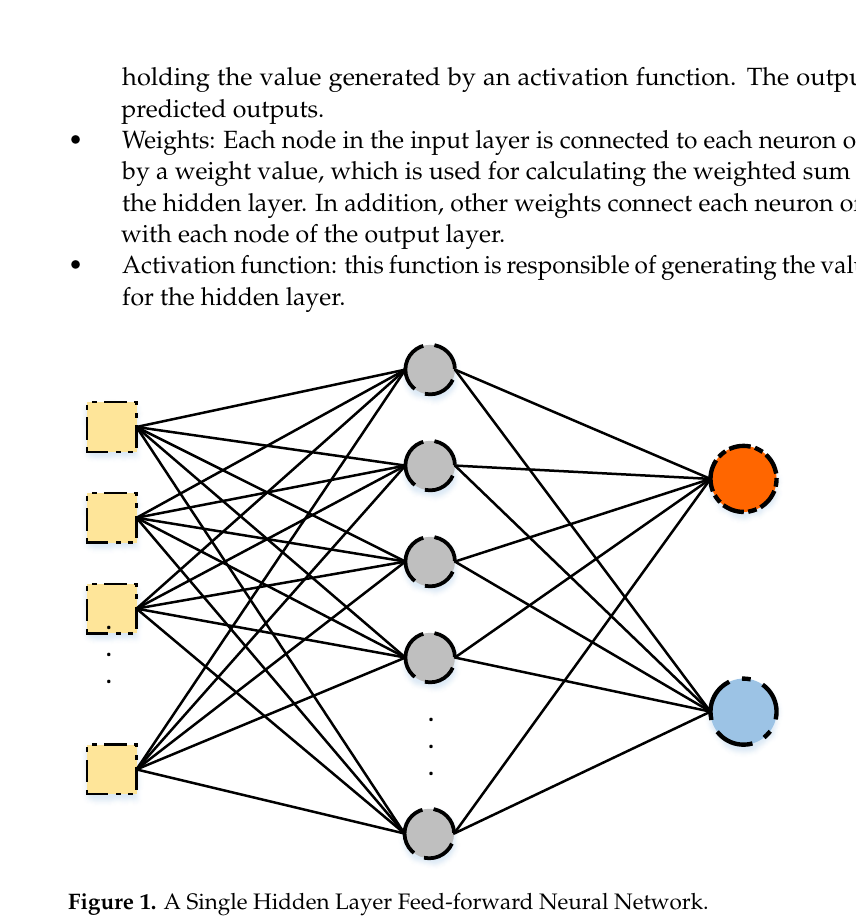
Figure 1. A Single Hidden Layer Feed-forward Neural